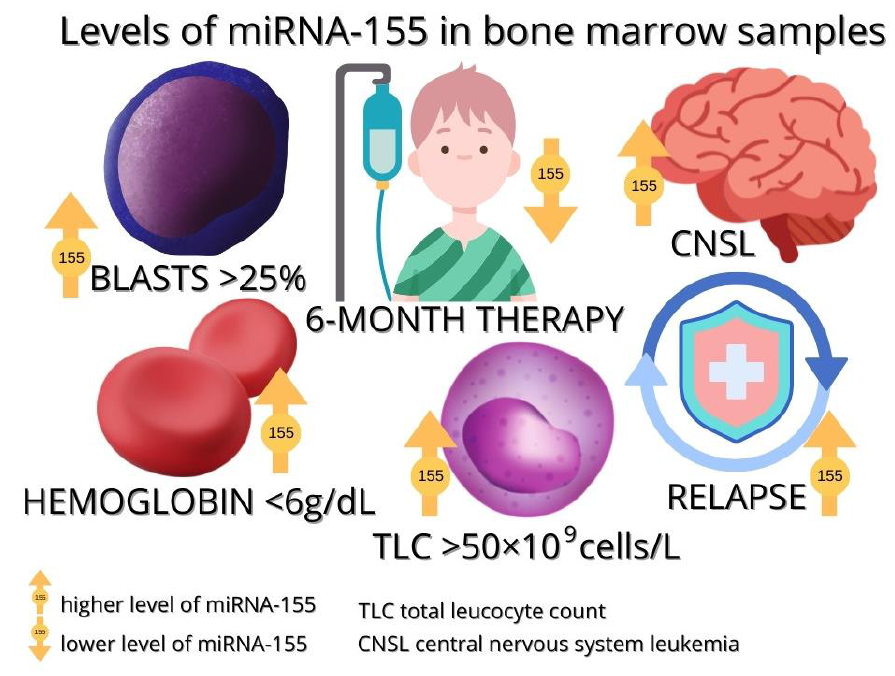
Figure 3. The level of miRNA-155 in bone marrow samples from children with ALL.